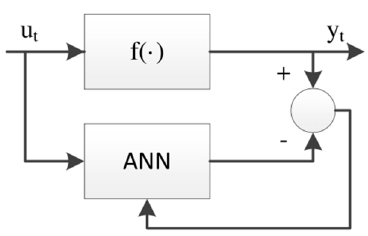
Figure 1. Identification based on neural networks.